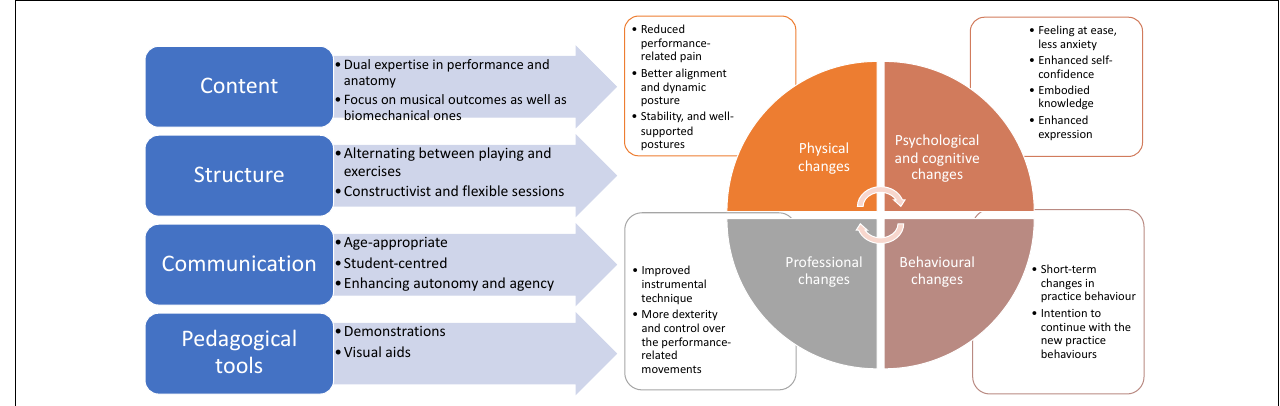
FIGURE 2 | Overall